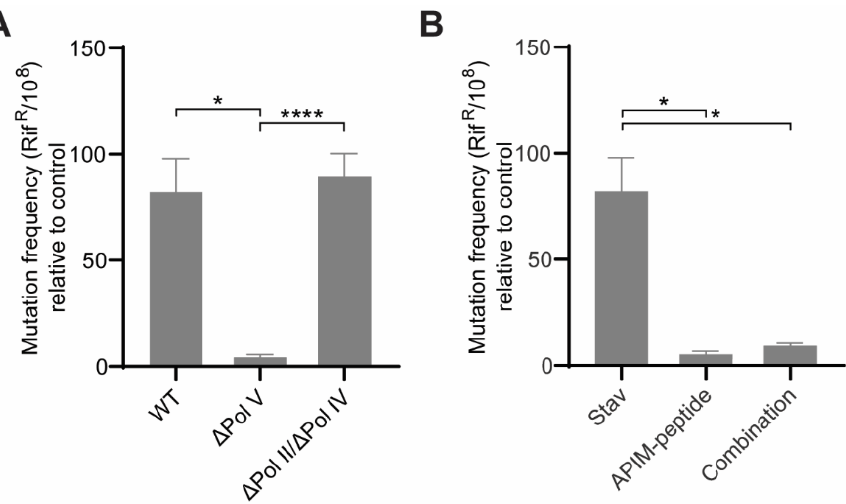
Figure 2. Stavudine-induced mutagenesis in Escherichia coli MG1655 is driven by the translesion synthesis (TLS) Pol V. ( A ) Data represent the average increase in mutation frequency using the Rif R assay after treatment of stavudine (Stav, 0.32 µ g/mL), compared to untreated control for E. coli MG1655 wild type (WT) and TLS polymerase deletion strains ( ∆ Pol V and ∆ Pol II/Pol IV). ( B ) Data represent the average increase in mutation frequency using the Rif R assay after treatment of stavudine (Stav, 0.32 µ g/mL), APIM-peptide (26 µ g/mL) and a combination (Stav + APIM-peptide), compared to untreated control for E. coli MG1655 wild type (WT). The mutation frequency from the stavudine-treated WT cells (WT and Stav) are from 14 independent biological replicas. The mutation frequencies from the remaining samples ( ∆ Pol V and ∆ Pol II/Pol IV, APIM-peptide and combination) are from 5 independent biological replicas, where 3 technical replicates were plated from each biological replicate. Unpaired Student’s t -test, two-tailed, **** p < 0.0001 and * p < 0.05. We have previously shown that peptides containing the PCNA interacting motif APIM, bind to the β -clamp and block the function of Pol V [21]. Here we show that the APIM- peptide was able to reduce the mutation frequency induced by stavudine when these were combined (combination) (Figure 2B), further supporting a Pol V-dependent mutagenesis. 3.3. Stavudine Treatment Induces only Minor Changes in Central Carbon Metabolite